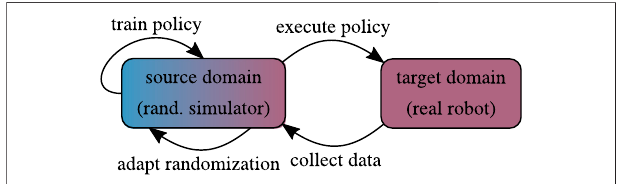
FIGURE 5 | Conceptual illustration of adaptive domain